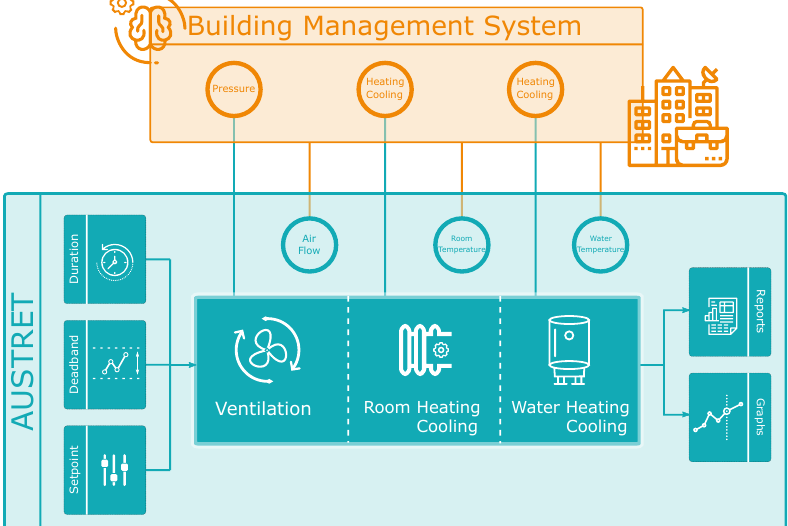
Figure 3. AUSTRET